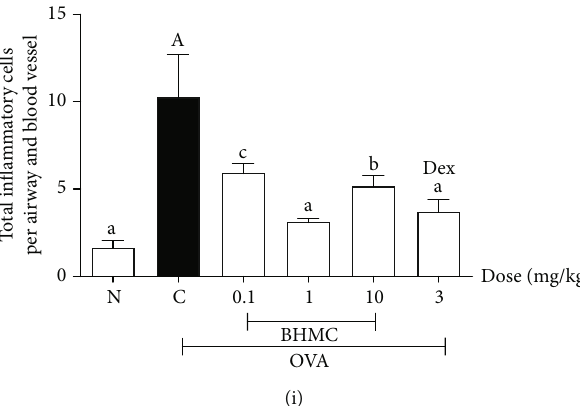
Figure 4: The e ff ects of BHMC on the in fi ltration of in fl ammatory cells in peribronchial and perivascular regions of OVA-induced mice. After BALF was collected, the lungs and trachea of the mice ( n = 8 per group) were processed into tissue sections and stained with H&E for the evaluation of cellular in fi ltration. The representative images of lung sections from the (a) OVA group, (b) PBS group, (c) 0.1 mg/kg BHMC group, (d) 1 mg/kg BHMC group, (e) 10mg/kg BHMC group, and (f) DEX group. The in fl ammatory cells are indicated by the white arrows. Representative images of lung sections were taken at 400x magni fi cation (40x for objective lens and 10x for ocular lens) using a light microscope. The results are also expressed quantitatively by counting the number of in fi ltrated cells at the (g) peribronchial region, (h) perivascular region, and (i) total for both peribronchial and perivascular regions. The values are expressed as mean ± SEM . c: P < 0 : 05 , b: P < 0 : 01 , and a: P < 0 : 005 , signi fi cantly di ff erent from the OVA group. A: P < 0 : 005 , signi fi cantly di ff erent from the N